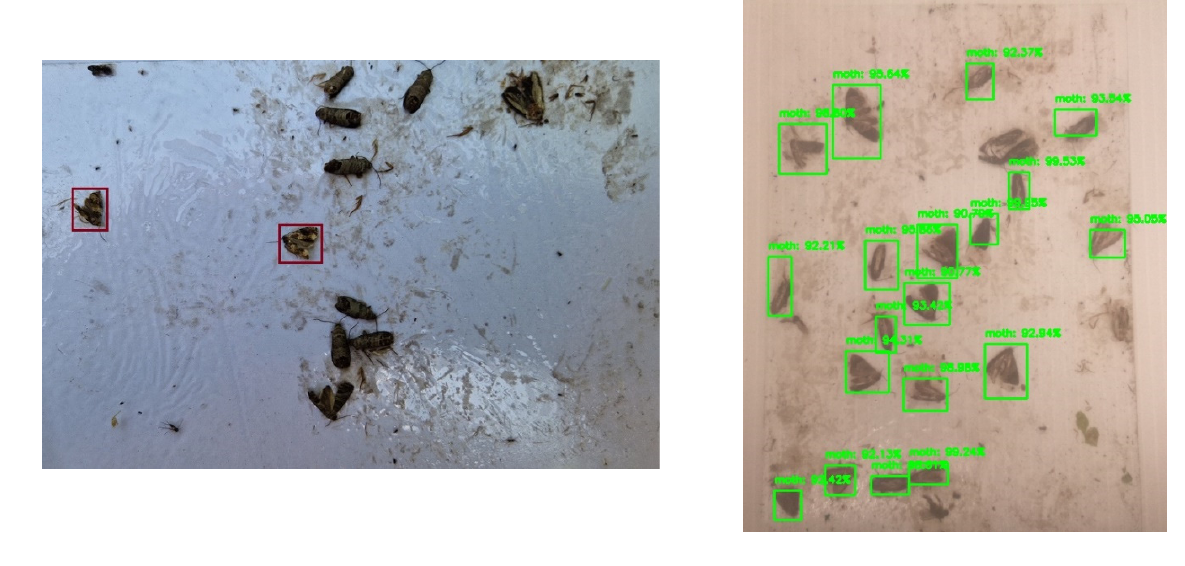
Figure 6. ( a ) Trap image with C. pomonella and Light Brown Apple moth (red boxes); ( b ) undetected touching insects.